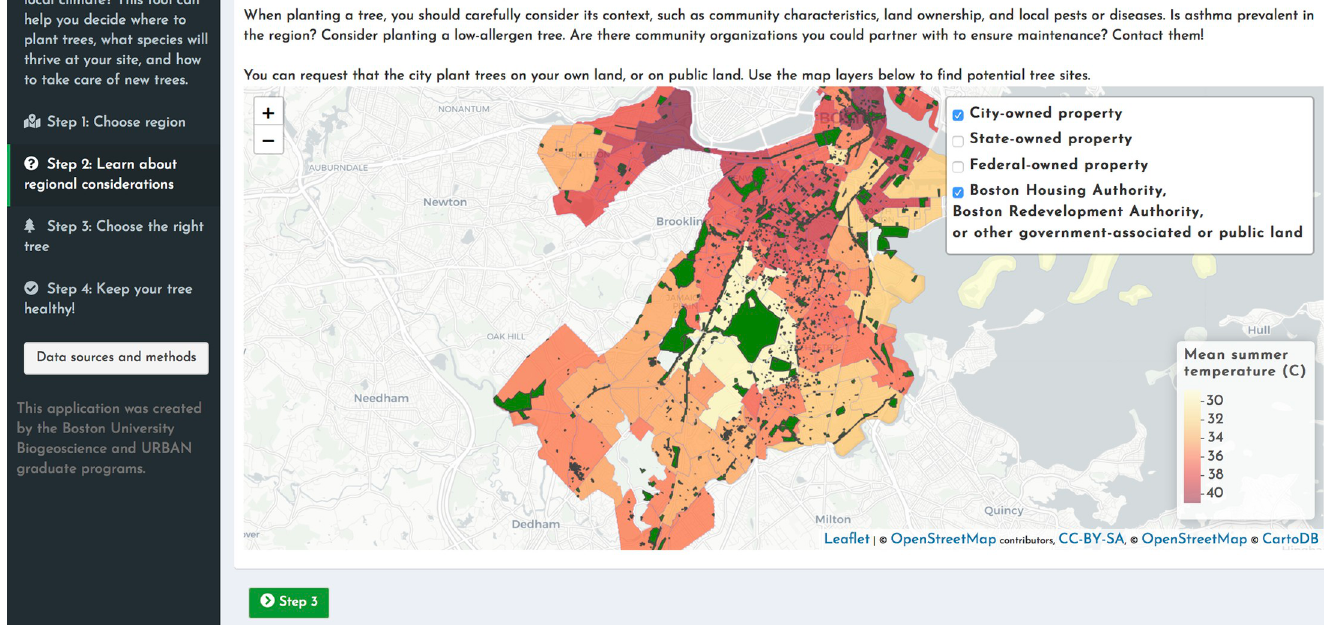
Fig 2. “Step 2: Learn about regional considerations”. The second page of the tool displays a map of Boston with additional information that may influence decision- making within a census-tract, such as pest sightings, property ownership, and names of community organizations that may assist with planting or maintenance. Map tiles were republished under a CC BY license, with permission from CARTO, original copyright 2020. Data courtesy of OpenStreetMap (openstreetmap.org; OpenStreetMap contributors).